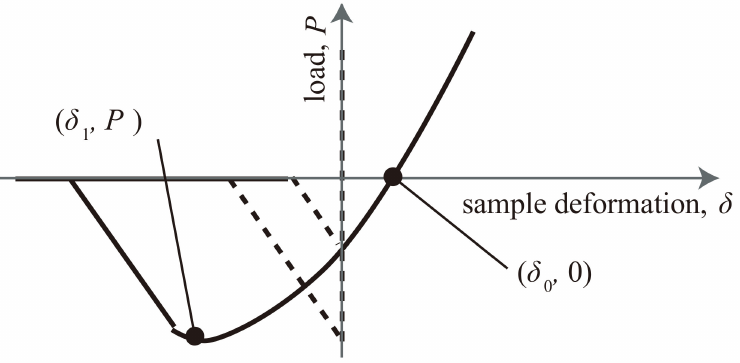
Figure 1. A schematic of the force–deformation